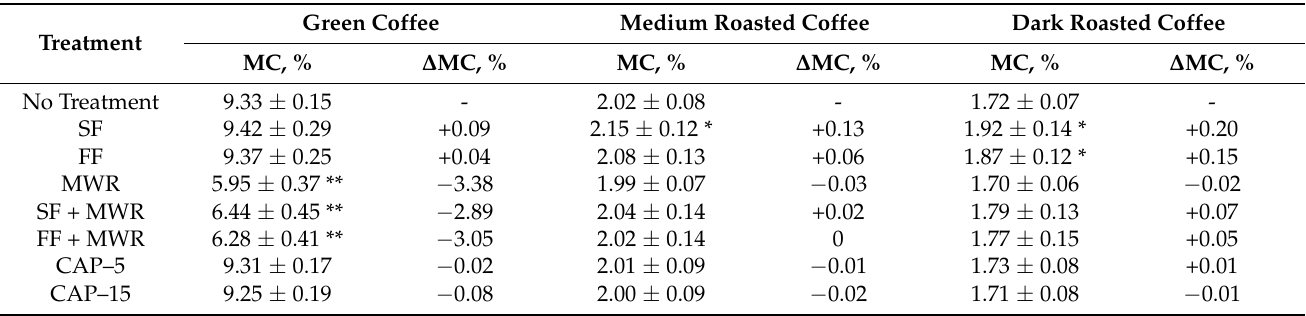
Table 1. Effect of different types of treatment on MC in coffee beans ( n =